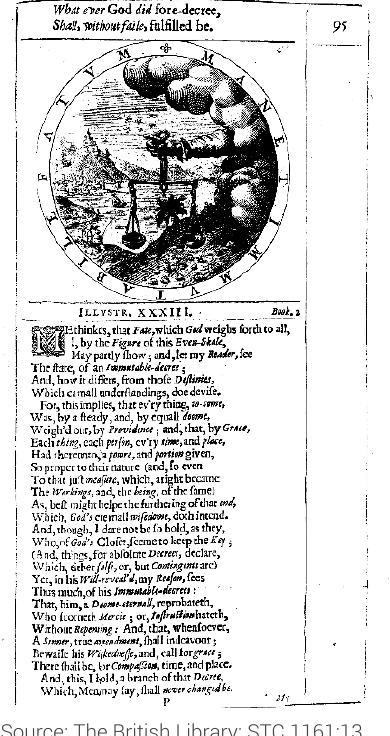
Source: The British Library; STC